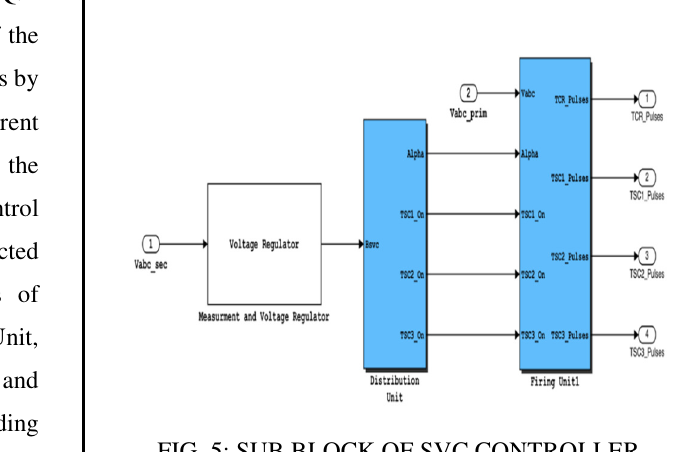
FIG. 5: SUB BLOCK OF SVC